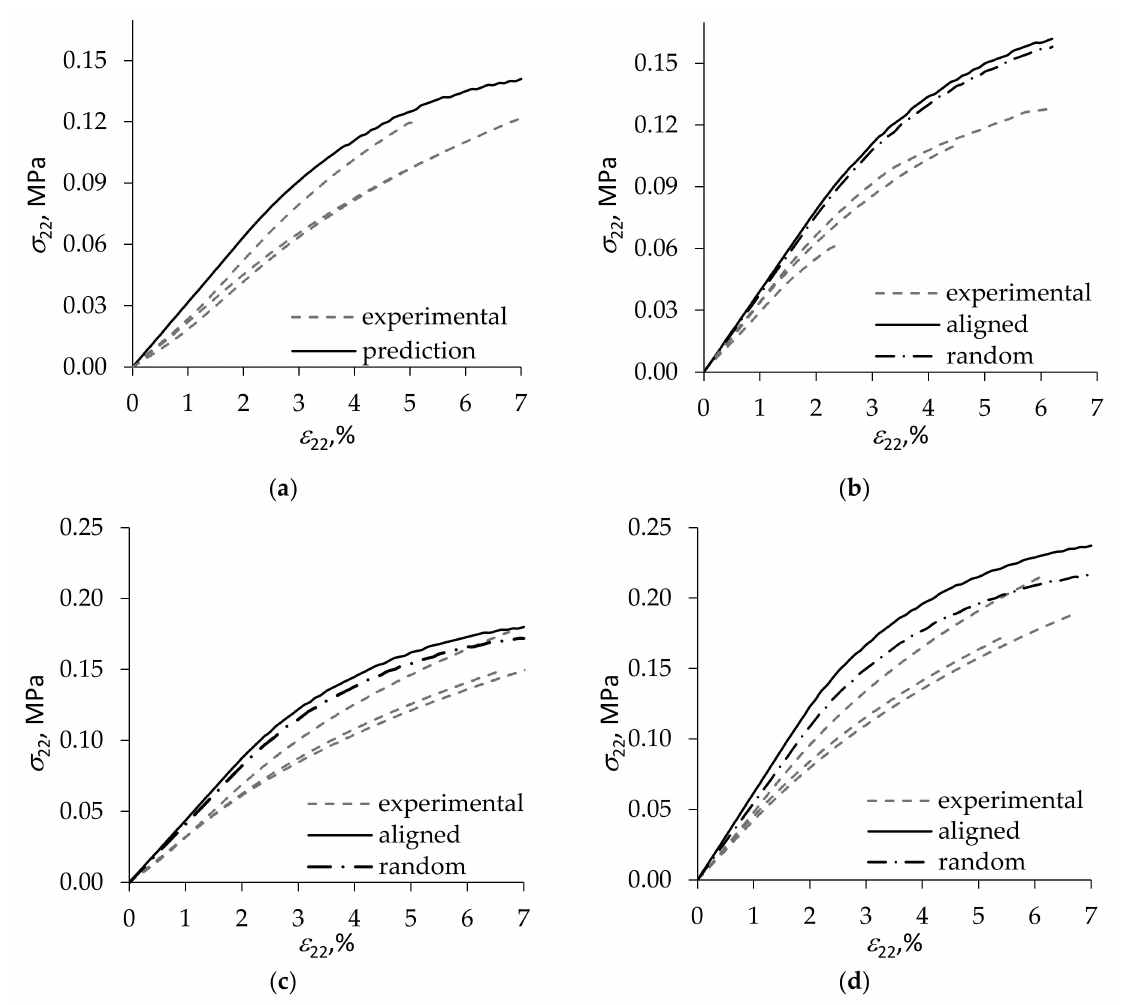
Figure 3. Stress–strain diagrams in tension transverse to the rise direction of ca. 40 kg/m 3 density foams with ( a ) 0, ( b ) 1, ( c ) 2, and ( d ) 5 wt.% loading of Cloisite ® 30B clay. Foam test results are plotted by dashed lines, and model predictions—by solid lines for clay platelets aligned with strut axis and by dash-dot lines for a random orientation of clay platelets in foam